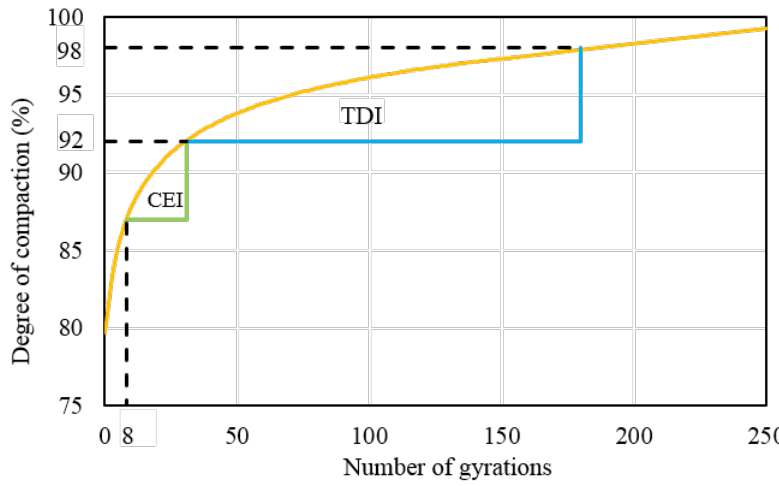
Figure 1. Schematic illustration of the definition of compaction energy index (CEI) and traffic densification index (TDI).